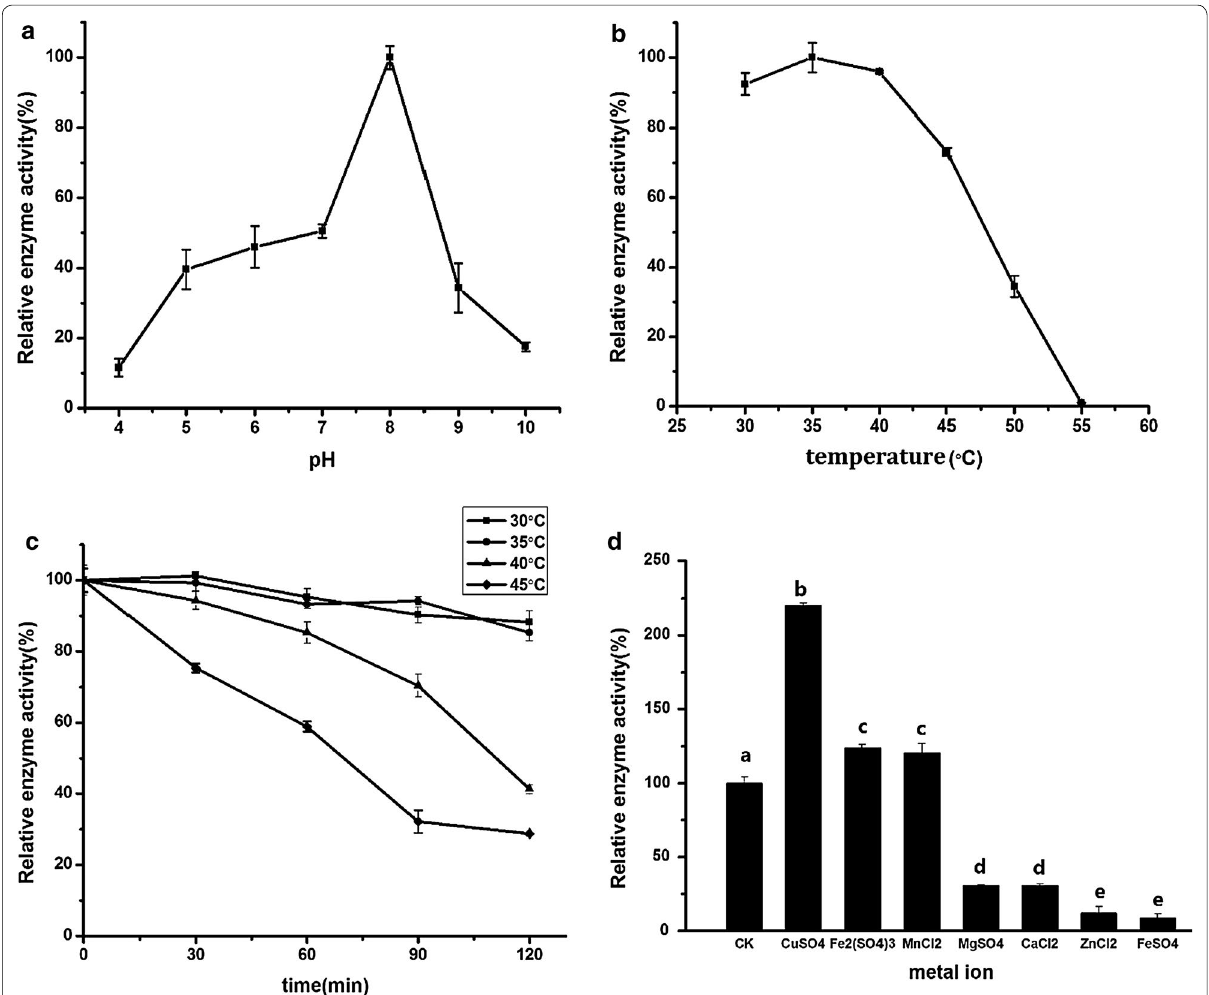
Fig. 4 The effects of pH value ( a ), temperature ( b ), incubation time ( c ) and metal ion ( d ) on the activity of glucoamylase. The pH optimum of proteinase was studied from 3 to 11. The temperature optimum was studied from 30 to 60 °C. Temperature stability was determined by holding the enzyme at 40–55 °C for 120 min. Metal ions included Mn 2 + , Mg 2 + , Ca 2 + , Cu 2 + , Zn 2 + , Fe 2 + and Fe 3 + . Values represent the mean replicates. Values with different letters indicate significant differences ( p <